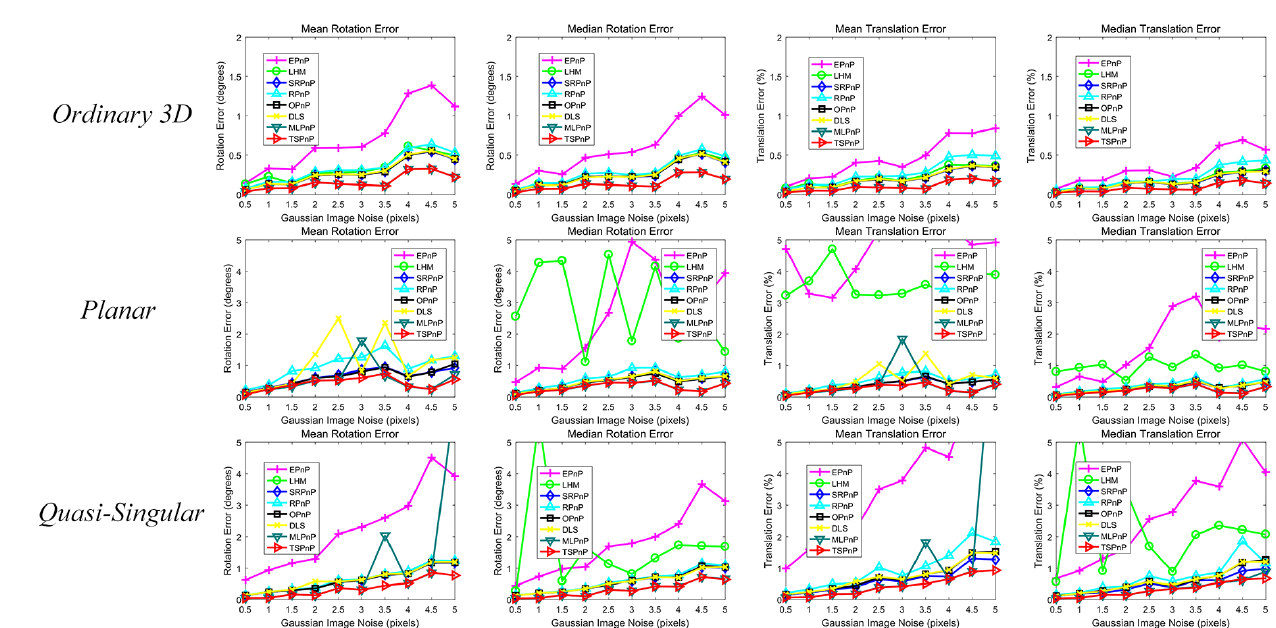
Figure 9. The rotation and translation errors under different noise of Level